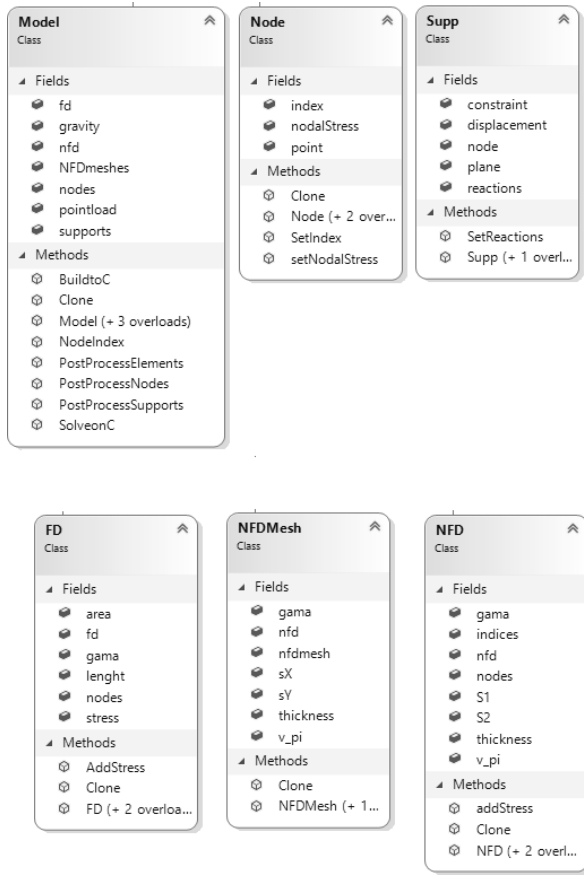
Figure 9: Class Diagram for application C#